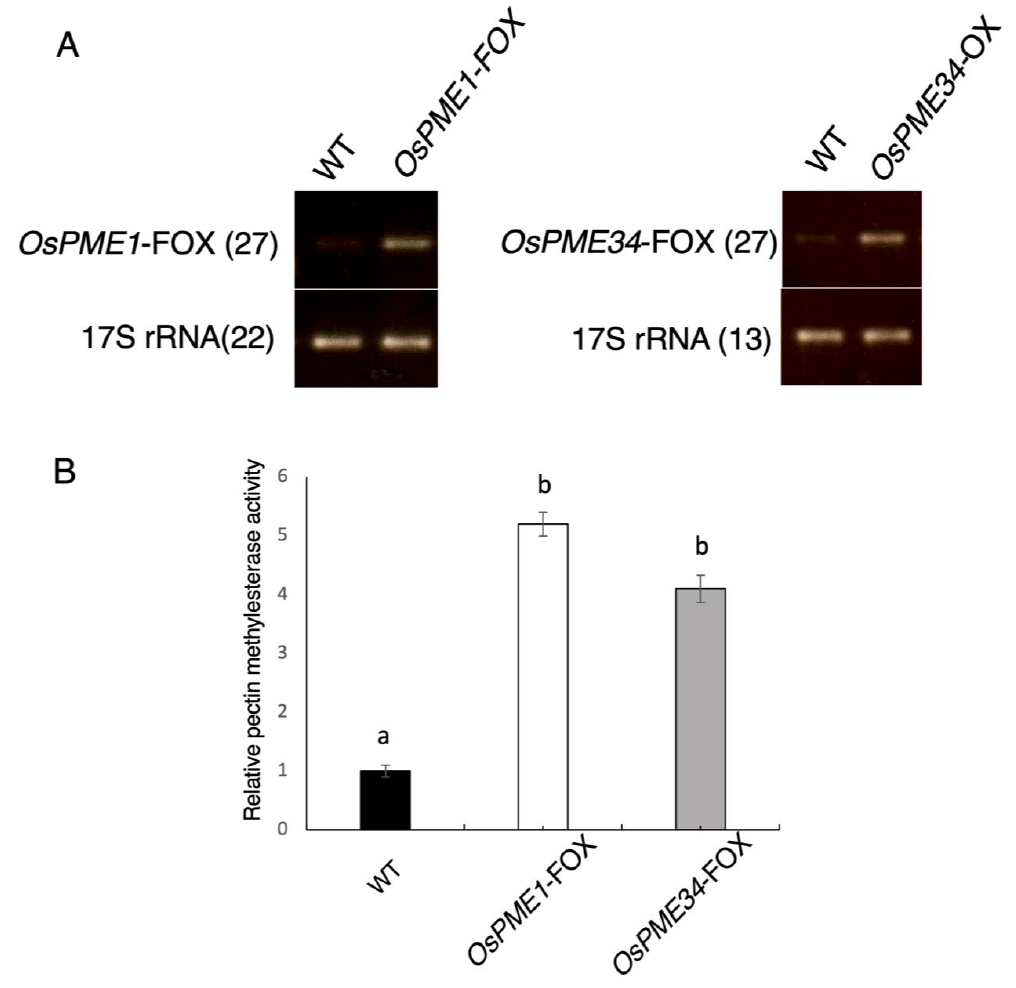
Figure 1. Characteristics of the OsPME1 -FOX and OsPME34 -FOX lines. ( A ) RT–PCR analysis of inflorescence transcripts from WT, OsPME1 -FOX and OsPME34 -FOX lines. The expression levels of OsPME1 -FOX and OsPME34 -FOX were higher than in the WT. The numbers in parentheses show the numbers of PCR cycles. These analyses were performed at least three times with similar results. ( B ) Pectin methylesterase activities in OsPME1 -FOX and OsPME34 -FOX. Pectin methylesterase activity is shown as the ratio of the activity in each FOX line inflorescence to that in the control. Error bars shows the SD ( n = 3). Letters in each panel show significant differences at p < 0.01 (Tukey’s